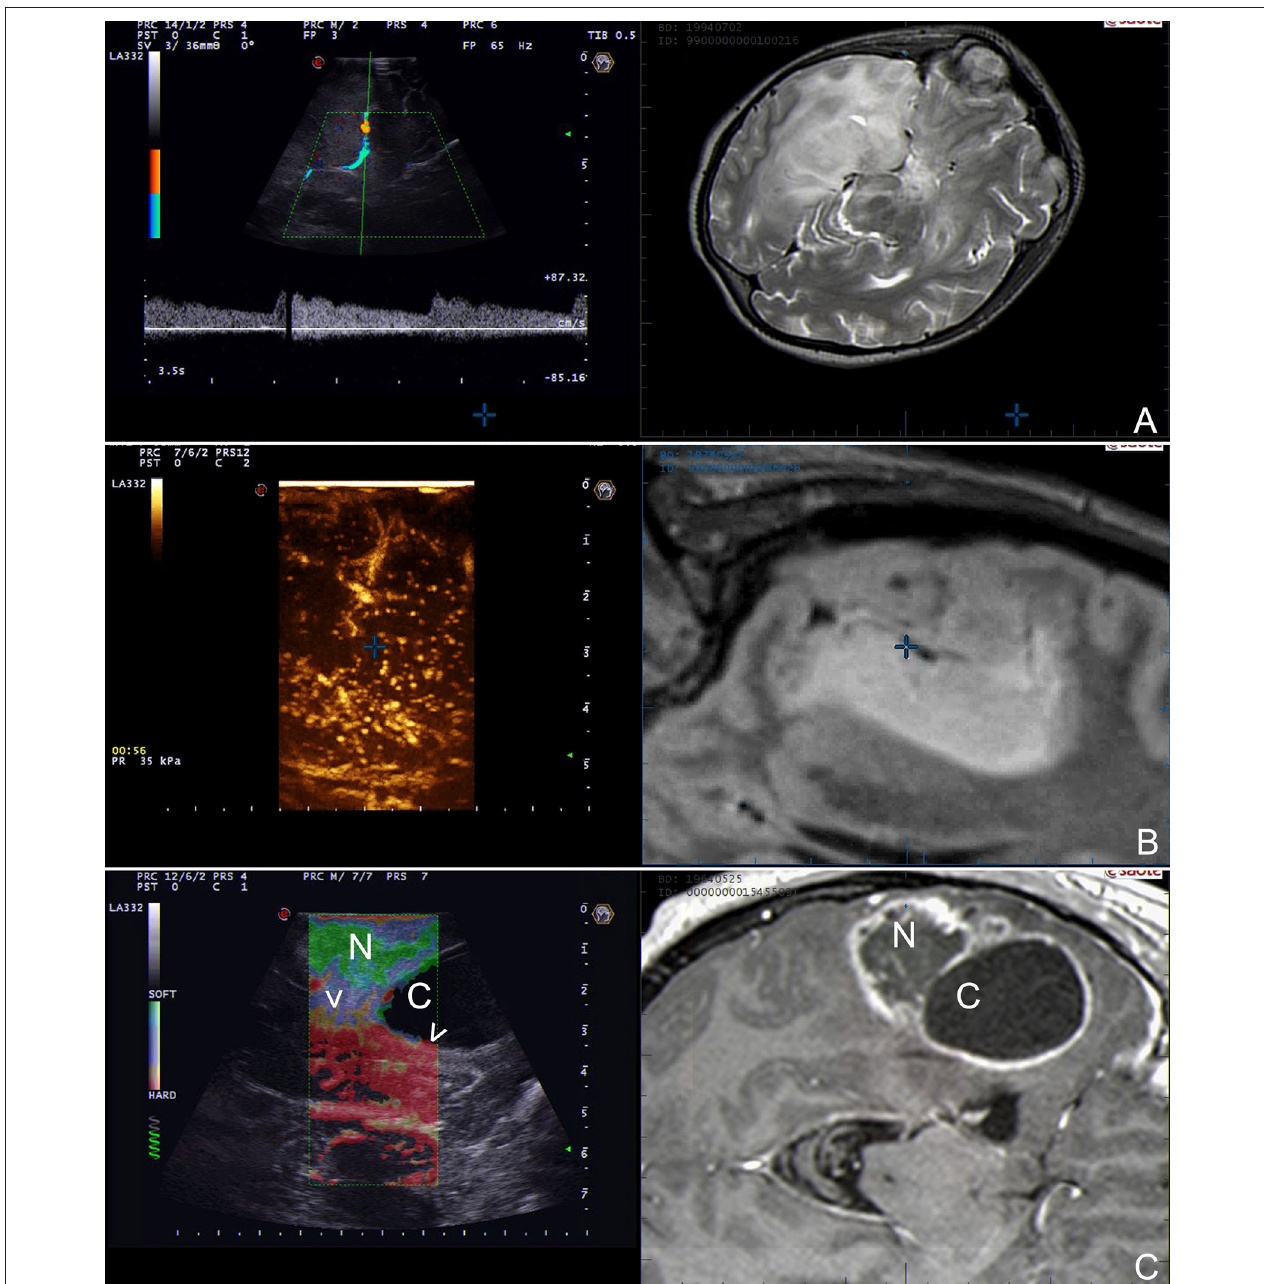
FIGURE 4 | Navigated ioUS (advanced modalities). (A) Color and spectral Doppler in a case of left temporo-insular anaplastic oligodendroglioma. (B) Contrast enhanced ultrasound in a case of left insular anaplastic astrocytoma. (C) Strain elastography in a case of left temporal glioblastoma; note the differences between the necrotic and the cystic areas and the interface with surrounding brain. Exploiting the continuous comparison between ioUS an pre-operative MRI is possible to understand US images and to infer about US and MRI correspondences. Legends are as follow: arrow heads: interface between tumor and brain; N: necrotic part of the tumor; C: cystic part of the